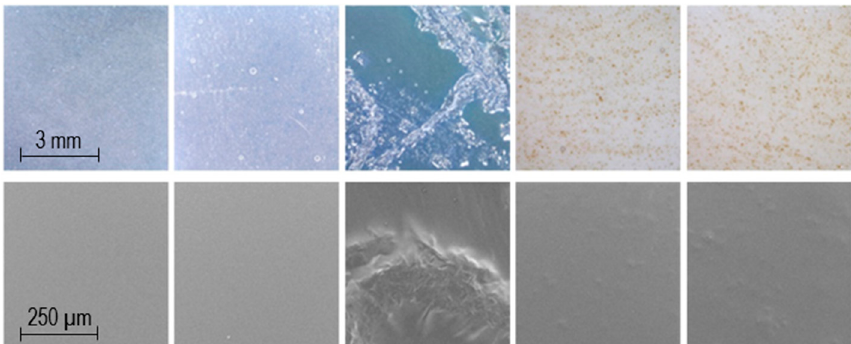
Figure 5. From the left, unloaded film, drug-loaded film, 2% drug-loaded film, unloaded film with liver powder, and drug-loaded film with liver powder. The upper row is taken with a handheld digital microscope, and the lower row displays scanning electron microscopy (SEM) images.